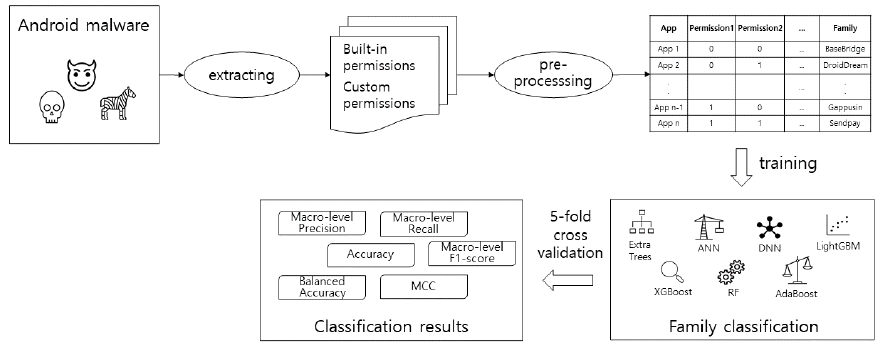
Figure 2. The schematic view of our malware family